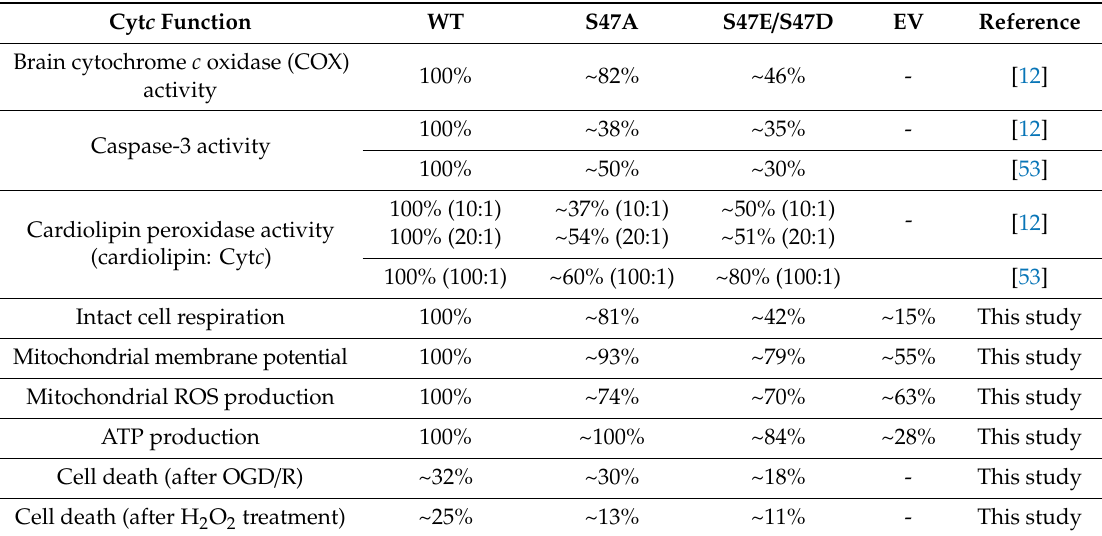
Table 1. Summary of the e ff ect of WT, S47A, and S47E Cyt c on di ff erent mitochondrial functions involving Cyt c .